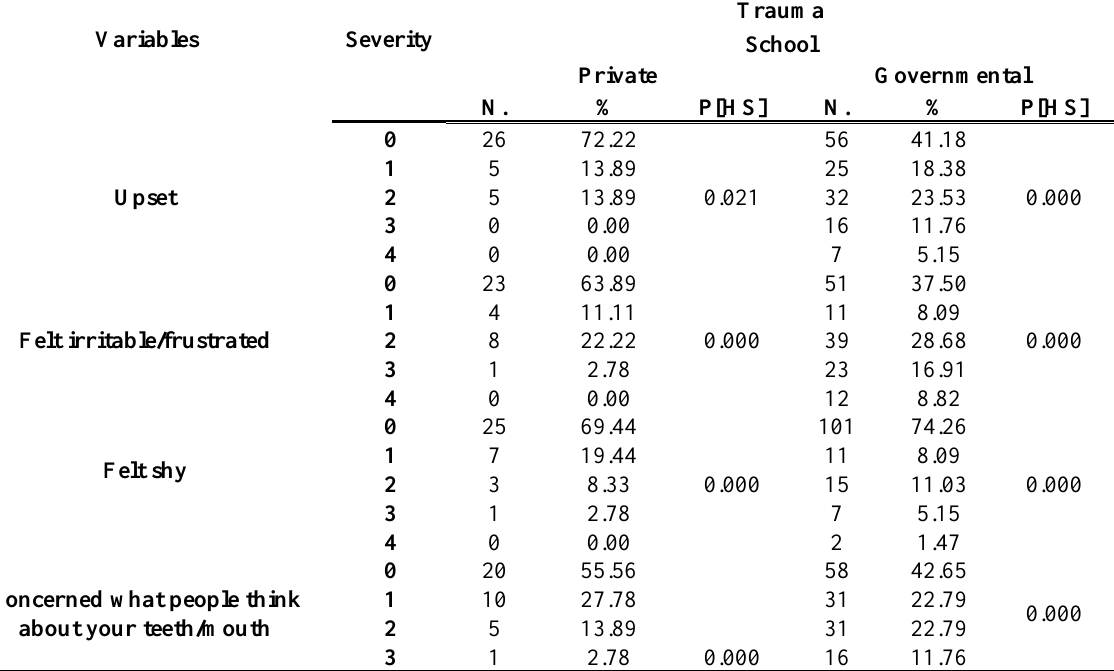
Table (4c): The association of traumatic dental injuries and quality of life regarding emotional well- being by school types.